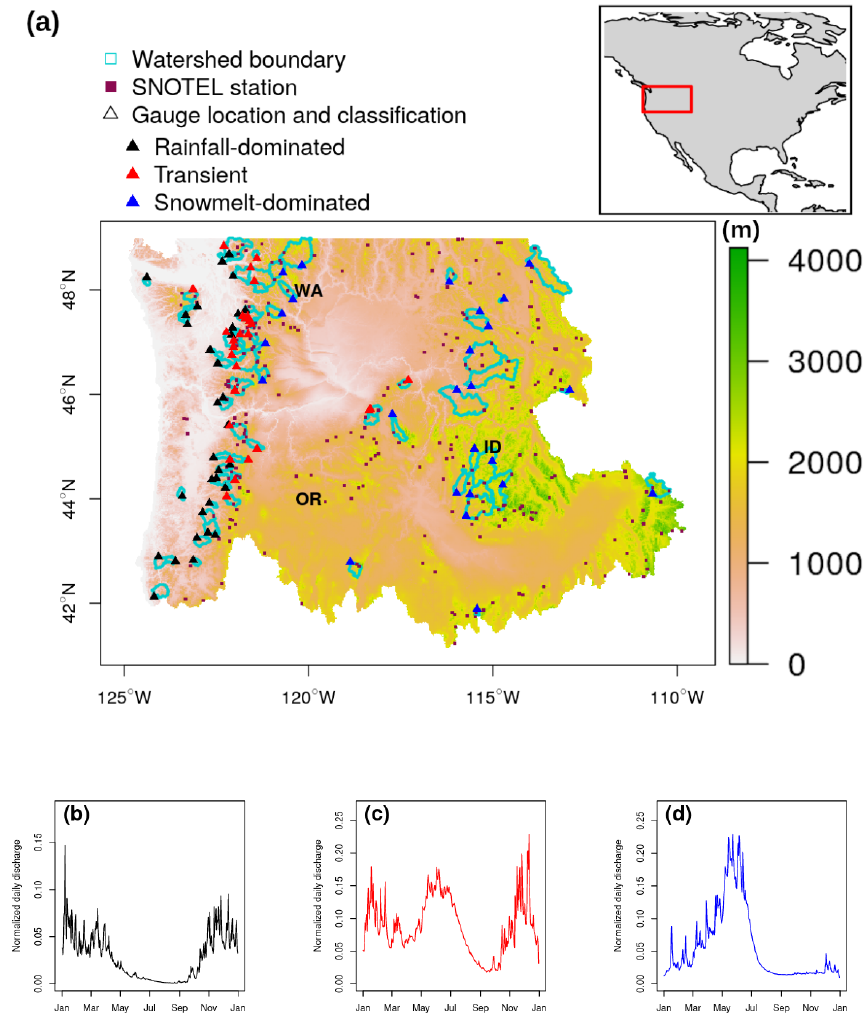
Figure 1. (a) Elevation (m) shading map showing the Pacific Northwest Hydrologic Unit, 86 selected stream gauges (triangles), and their drainage area (cyan delineation lines), as well as SNOTEL stations (brown squares). Examples of annual hydrographs of (b) rainfall- dominated, (c) transient, and (d) snowmelt-dominated watersheds. Panels (b–d) are based on 2009–2018 daily flow data at three sites: 12043300 (48.2 ◦ N, 124.4 ◦ W), 12048000 (48 ◦ N, 123.1 ◦ W), and 10396000 (42.7 ◦ N, 118.9 ◦ W),